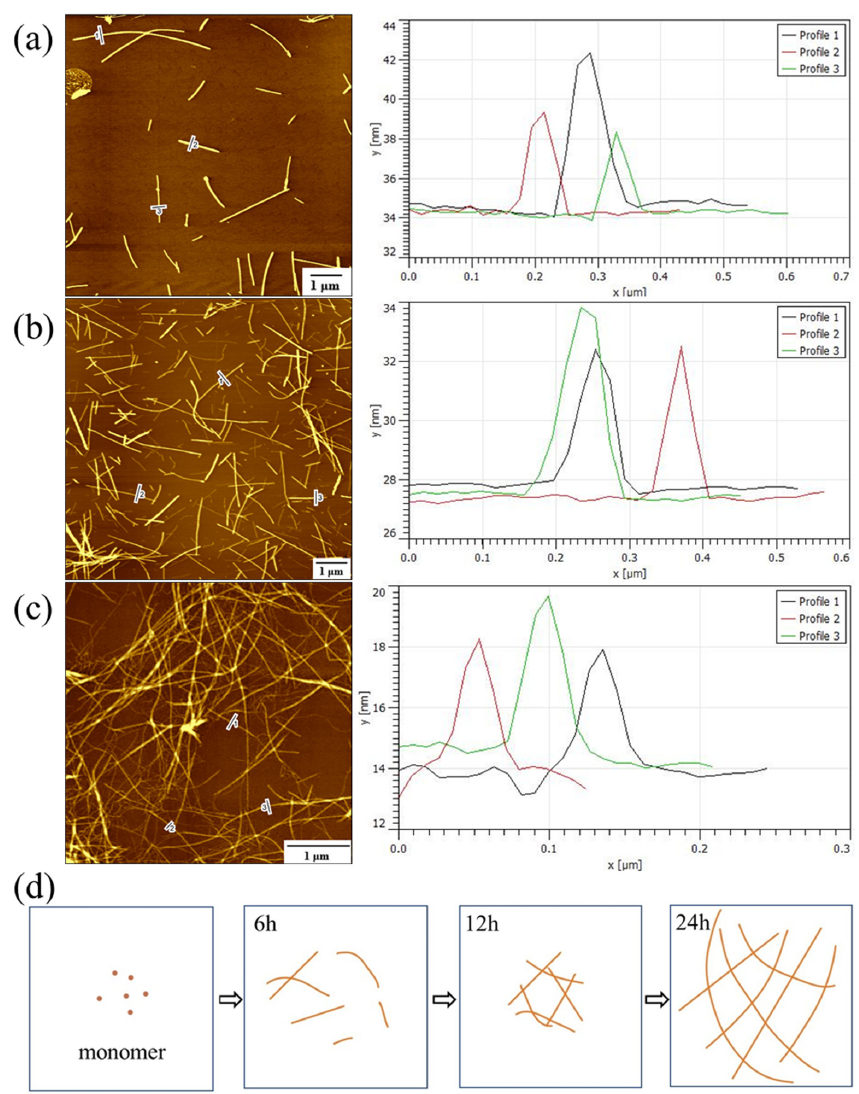
Figure 4. ( a – c ) AFM height images and section analysis of PNFs under different reaction times: ( a ) 6 h, ( b ) 12 h, and ( c ) 24 h. ( d ) Formation process of PNFs with different reaction times.